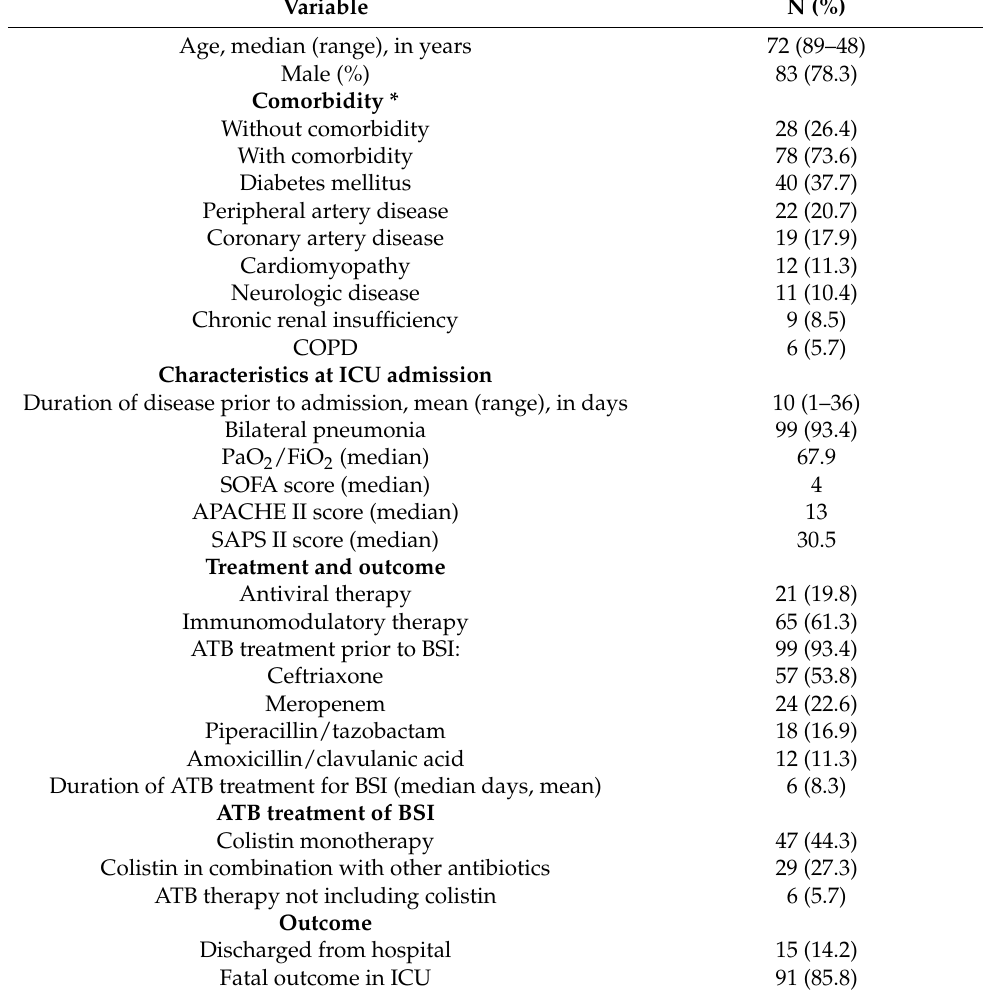
Table 1. The characteristics of patients with healthcare-associated bloodstream infections due to multidrug-resistant Acinetobacter baumannii in the COVID-19 intensive care units at the Dubrava University Hospital during the second wave of the COVID-19 pandemic (1 October 2020–28 February 2021) (N =